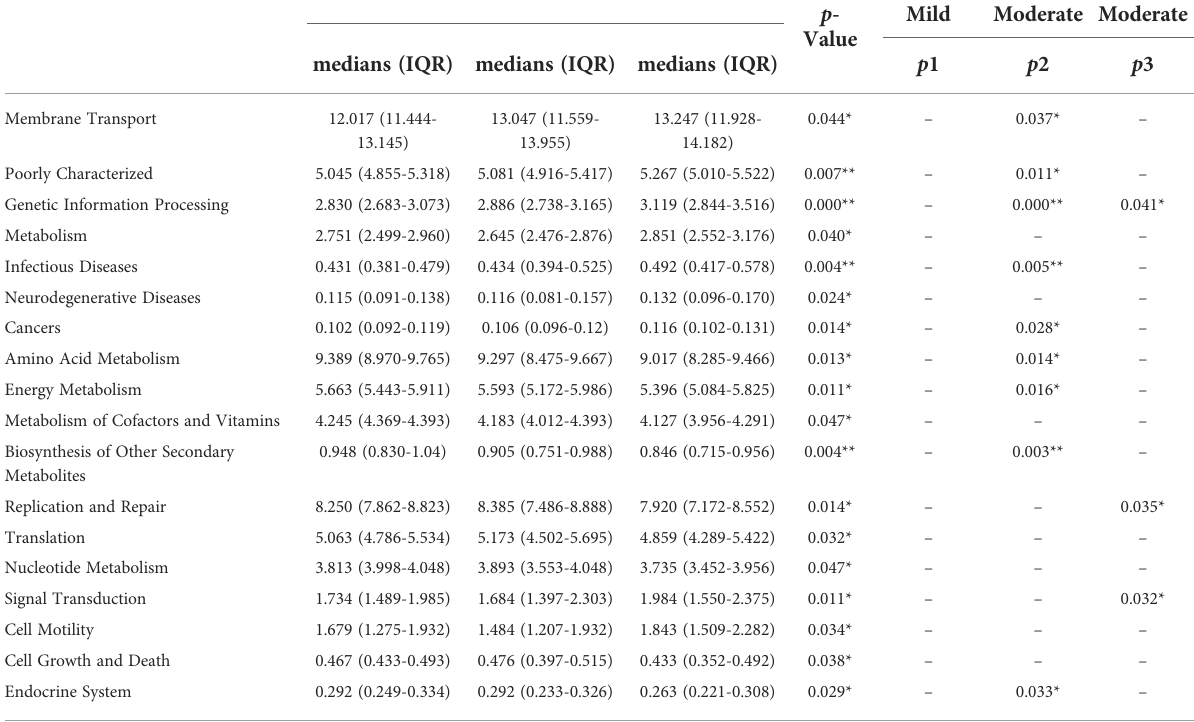
TABLE 3 PICRUSt-based examination of the gut bacterial functions among the three groups.